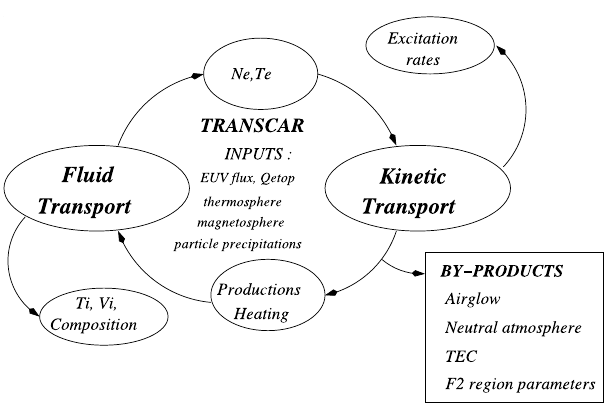
Fig. 1. Synopsis of the TRANSCAR